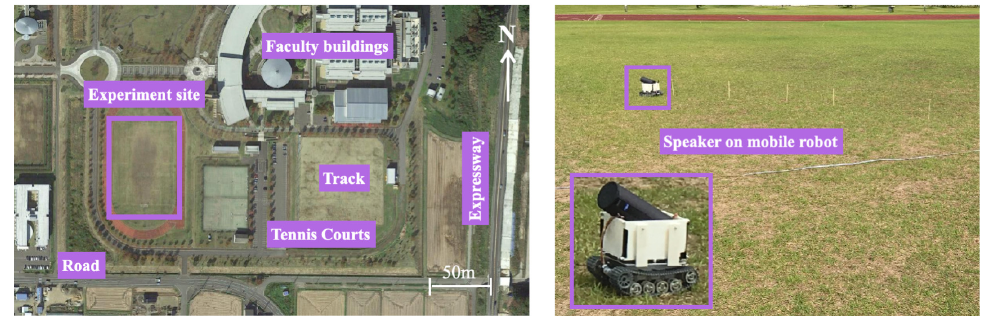
Figure 6. Aerial photograph showing the experimental environment ( left ) and UGV used to move the sound source positions ( right